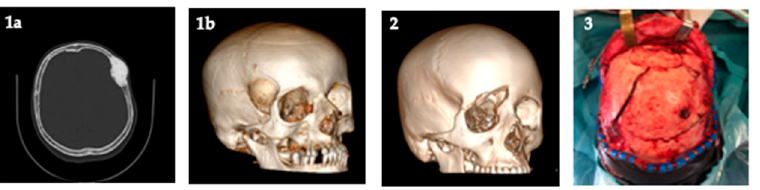
Figure 1. Example of causes that require cranioplasty (authors personal database images): ( 1a ) axial computerized tomography (CT) scan of tumor involving cranial bone; ( 1b ) 3D-CT scan of tumor involving cranial bone; ( 2 ) 3D-CT scan of depressed skull fracture; ( 3 ) surgical exposition of complex depressed skull fracture.